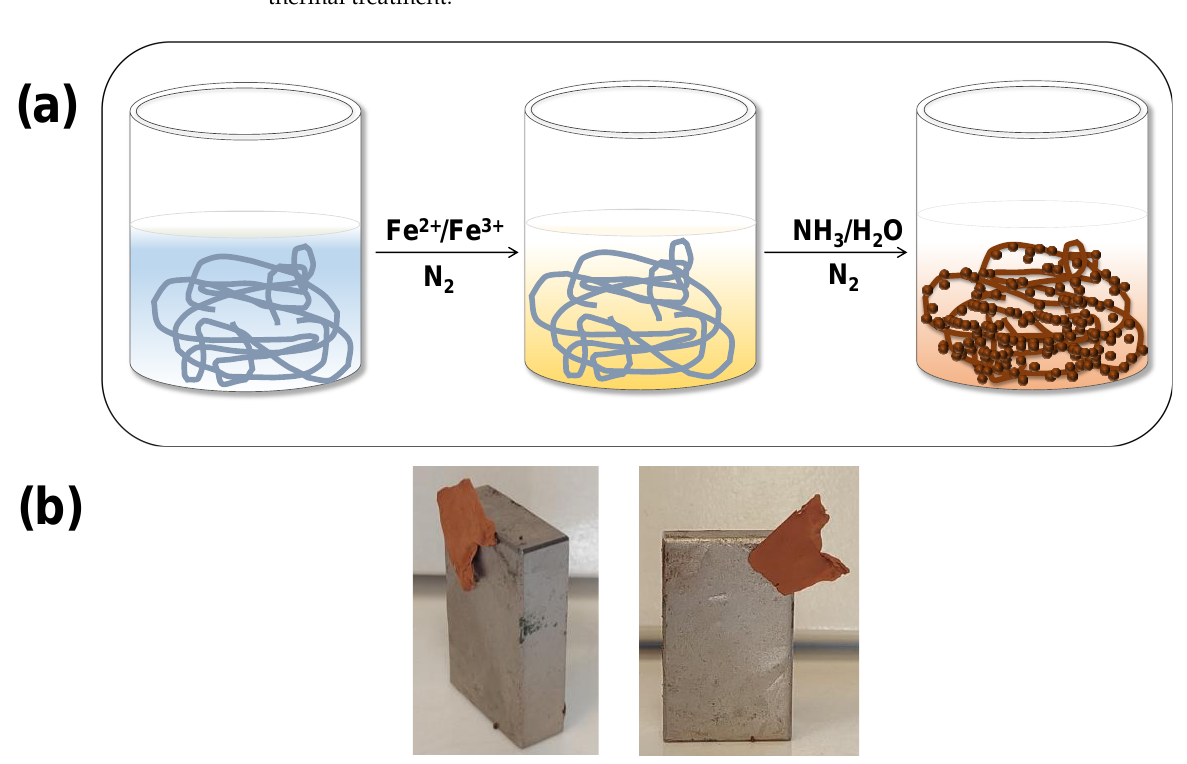
Figure 5. Schematic of the post-magnetization process followed for the preparation of the magnetically functionalized PMMA x - co- PDEAEMA y /PVP-Fe x O y electrospun fibrous adsorbents ( a ); photograph demonstrating the attraction of the membrane by an external magnet ( b ).